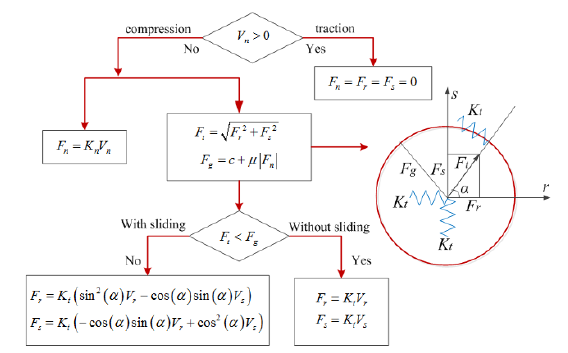
Figure 1. Flowchart for calculating force at joints